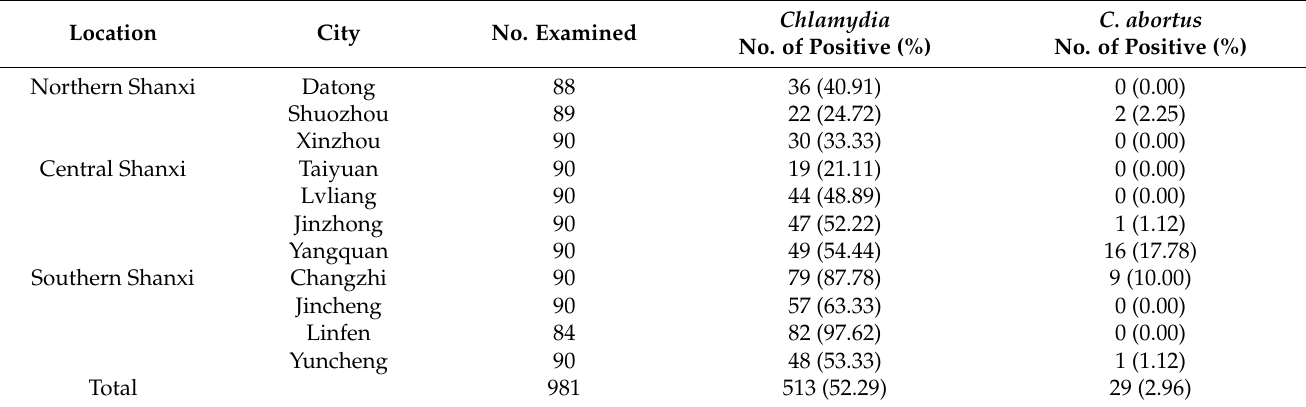
Table 2. Seroprevalence of Chlamydia and C. abortus in Cattle in 11 Cities of Shanxi